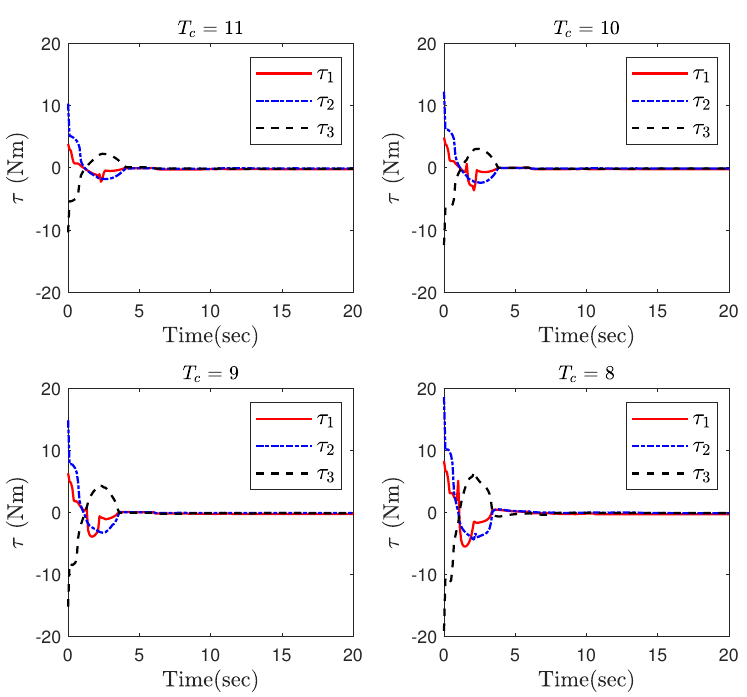
Figure 11. The control input in Part 2. The attitude and rotation velocity tracking errors are depicted in Figures 12 and 13, respectively. It is shown that the proposed controller results in much faster convergence with reduced settling time. To be more exact, the error trajectories under the proposed controller, the RFTAC, and the DOBPTATC were stabilized after roughly 8, 14, and 19 s, respectively. This means that the proposed approach reduces the convergence time by 42.8% and 57.9% with respect to the RFTAC and the DOBPTATC. Further, in contrast to